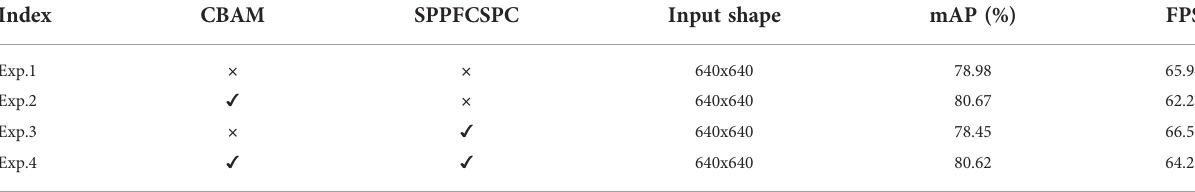
TABLE 3 The impact of the fusion of different modules of the model on the metrics. Index